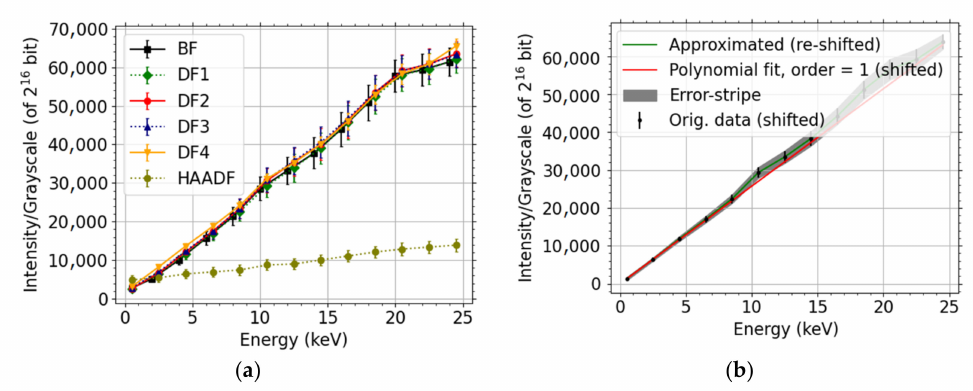
Figure 2. Calibration curves for the segments of detector. (Contrast DB, a.k.a. gain, equal to 83%, beam current = 1.56 pA, dwell time = 10 µ s) ( a ) as were, ( b ) CC in the case of DF4, with DL subtracted, and a polynomial fit of a sufficient number of values close to E = 0 eV used to estimate the